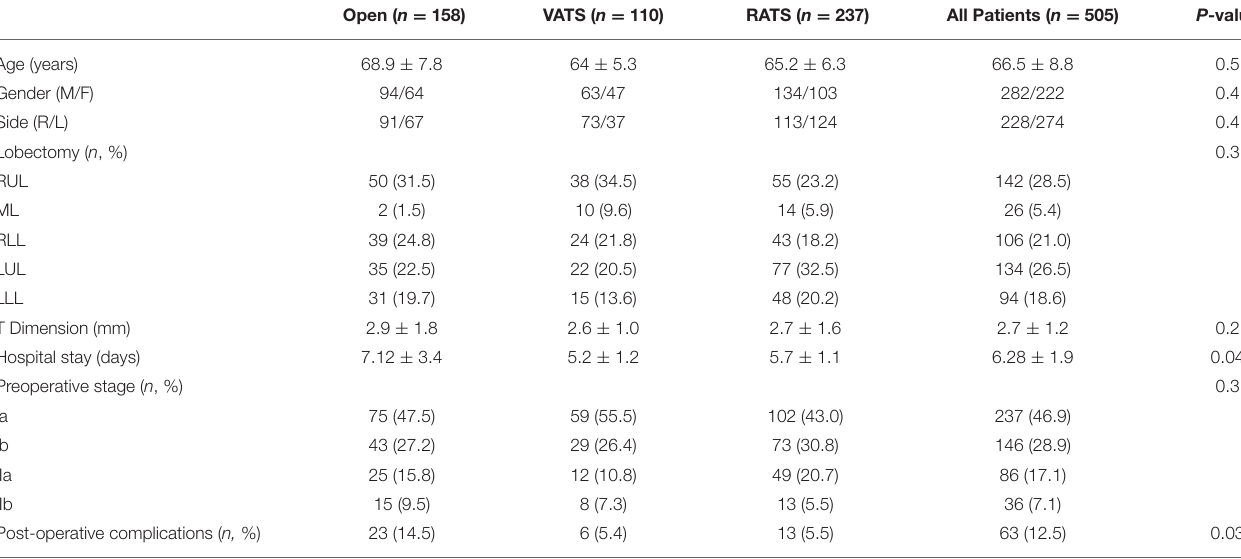
TABLE 1 | Demographic and surgical features in the Robotic, VATS, and Thoracotomy groups. Open ( n = 158) VATS ( n = 110) RATS ( n = 237) All Patients ( n = 505) P -value